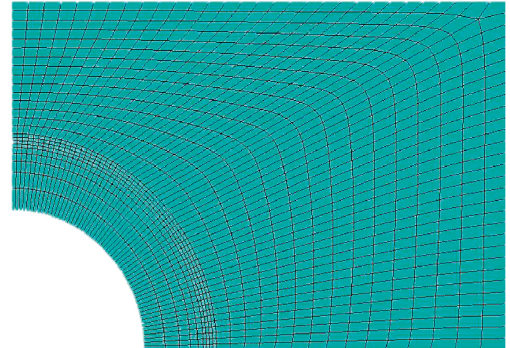
Figure 21: Plate meshing, front plate view of x - y .